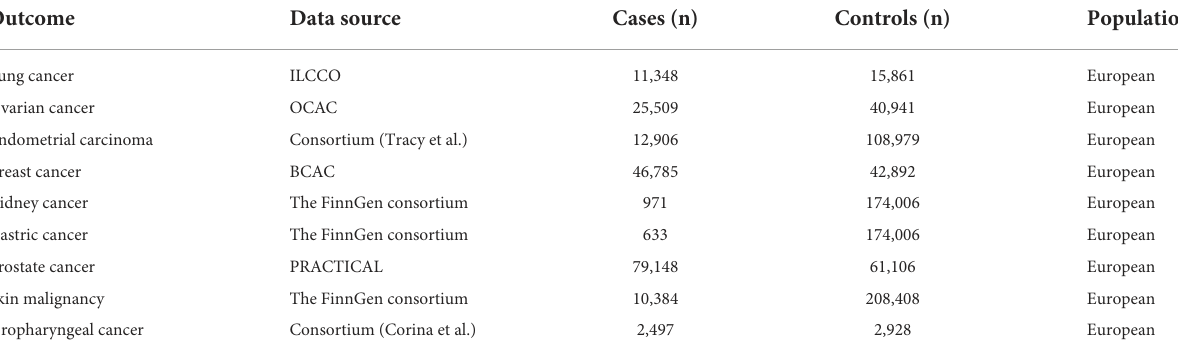
TABLE 1 Number of cancer cases and controls in the Mendelian randomization study on the association of processed meat and red meat intake with risk of site-specific cancer.